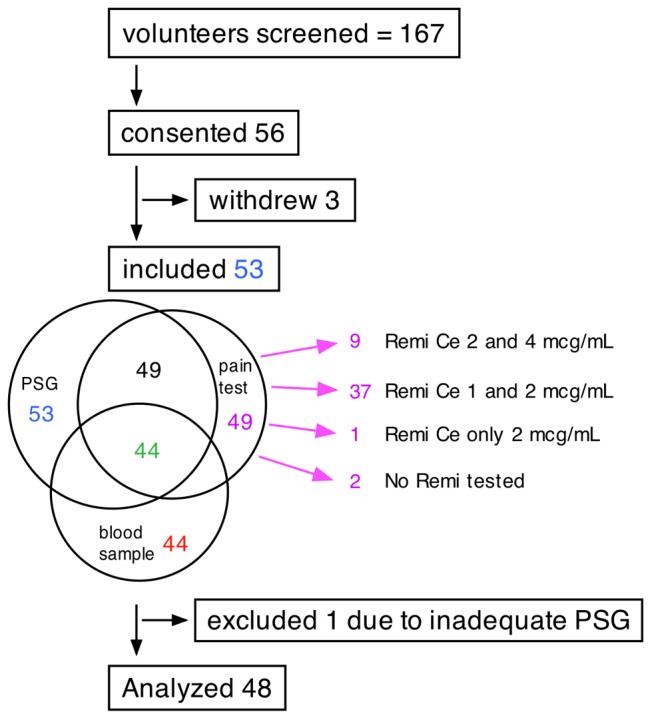
Volunteers and study procedures.A total of 167 volunteers were screened via telephone or a personal interview. Fifty six volunteers signed an informed concent; 3 of them withdrew before participation in any of the study procedures. All remaining 53 underwent an overnight polysomnography, but only 49 came for the pain test on the second study day. Blood was not drawn from 3 volunteers due to technical difficulties, while 2 more blood samples were lost before analysis was done; a total of 44 blood samples provided data on inflammatory and hypoxia markers. The first 9 volunteers were tested on remifentanil Ce of 2 and 4 µg/ml and all the remaining on 1 and 2 µg/ml. Two volunteers experienced intence nausea; one at the end and the other at the beginning of the first remifentanil Ce (2 µg/ml); the experiment was stopped in both cases, but pain-related measurements were acquired only in the first case. A pump malfunction prohibited the administration of remifentanil in 1 subject. One volunteer was excluded from the analysis due to an inadequate sleep study. Finally, data from 48 volunteers were included in the analysis.